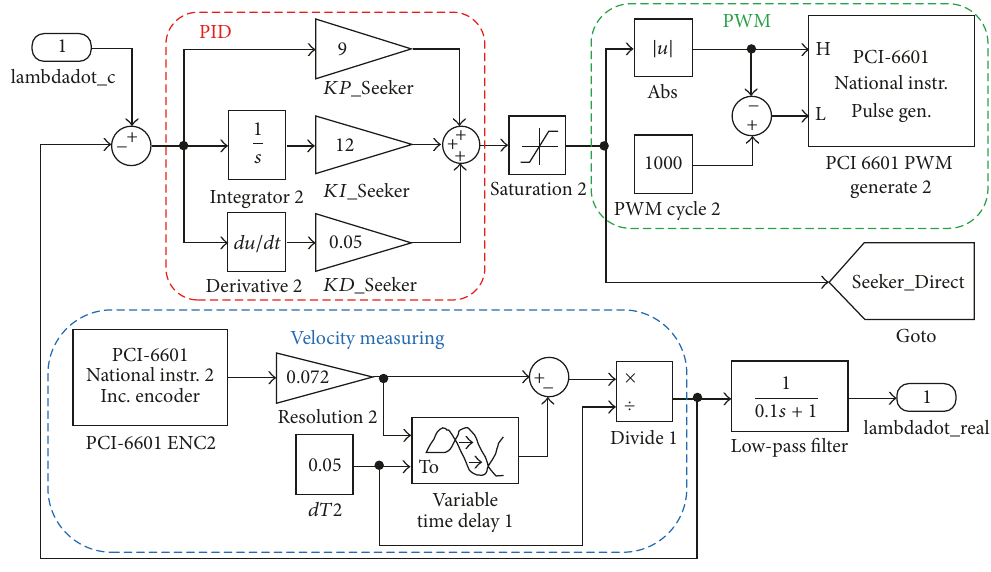
Figure 11: Seeker_Motor subsystem.